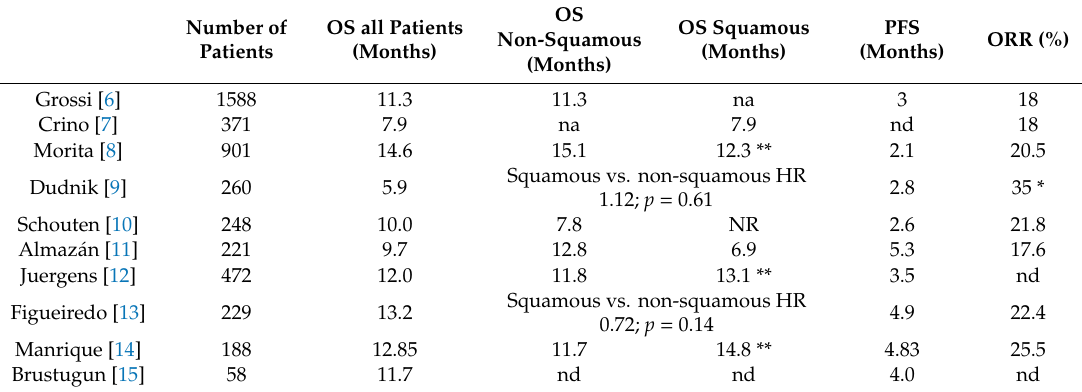
Table 2. Survival in patients treated with nivolumab in real-world